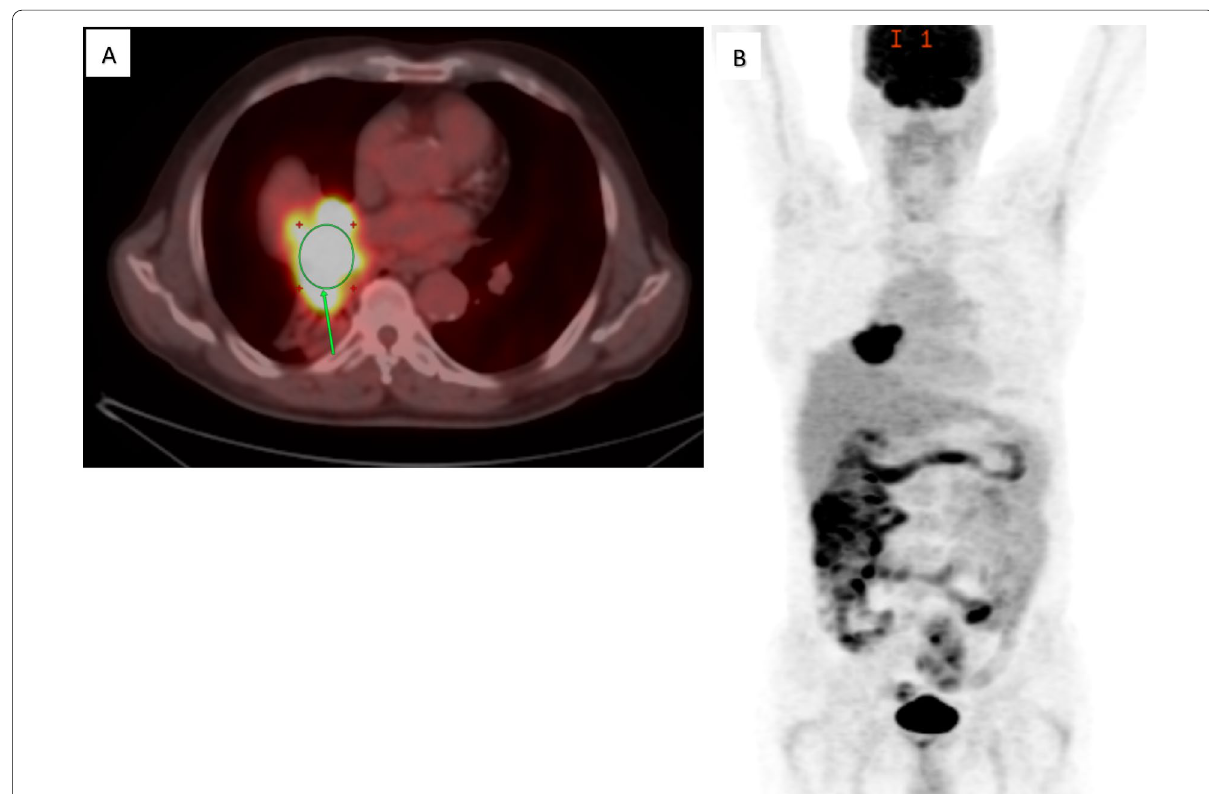
Fig. 4 66‑year‑old gentleman with recent bronchoscopy showing a right bronchial mass lesion. (Fig. 4). A – B (FDG) PET/CT. A Metabolically active large right lower lobe central peribronchial soft tissue mass lesion (arrow) is seen cuffing the left lower lobe bronchus with consequent narrowing of its lumen, the lesion measures about 74 44 mm and showing max.SUV ~ 17. B Full‑body coronal MIP PET showing the primary lung mass with × no other distant metastasis. The tissue sampling proved to be undifferentiated large cell carcinoma